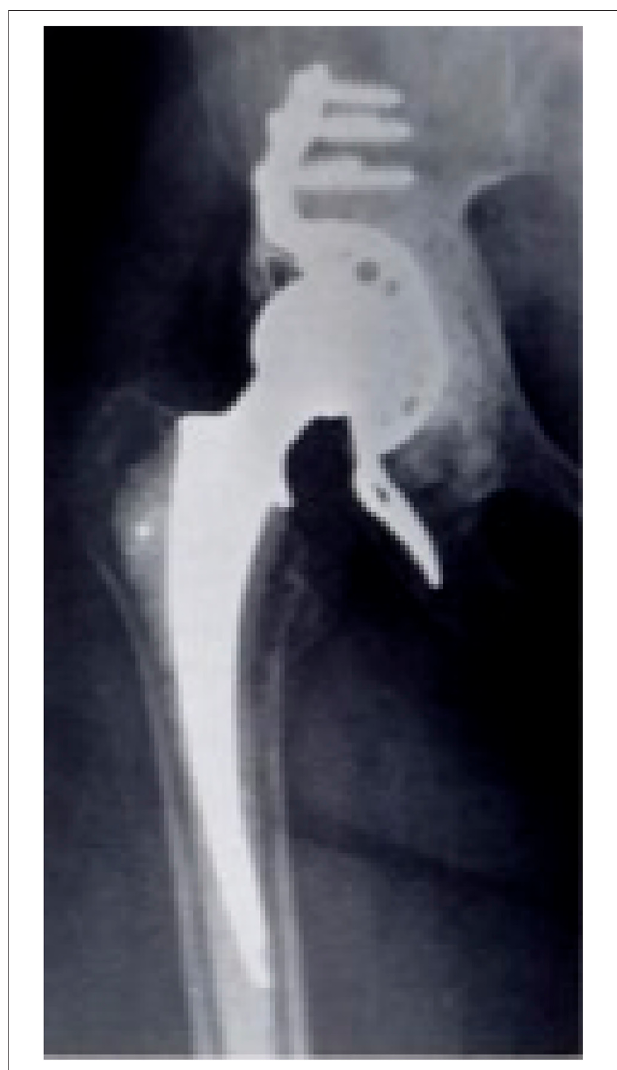
FIGURE 1 | Radiograph of a patient ’ s right hip with a BS cage (Rosson and Schatzker, 1992).